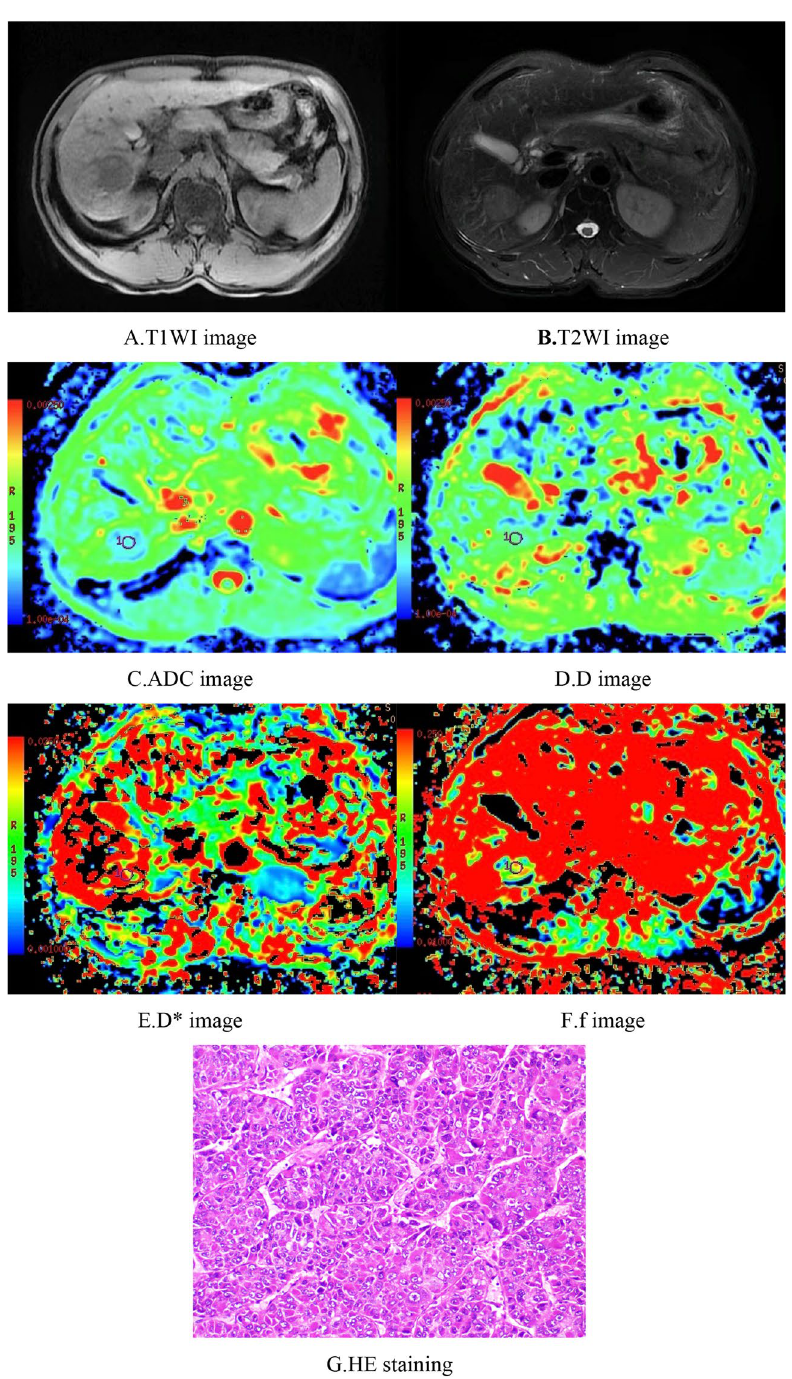
Figure 2. Male, 61 years old, HCC in the right hepatic lobe. ( A ) T1WI image. The lesion showed a low signal and a relatively clear boundary. ( B ) T2WI image.The lesion showed a slightly high signal, with a relatively clear boundary. ( C – F ) ADC, D, D*, and f images, respectively. The ADC value was 1.18 × 10 −3 mm 2 /s, the D value was 0.92 × 10 −3 mm 2 /s, the D* value was 30.8 × 10 −3 mm 2 /s, and the f value was 0.18. G. HE staining (*100) showed moderately differentiated HCC